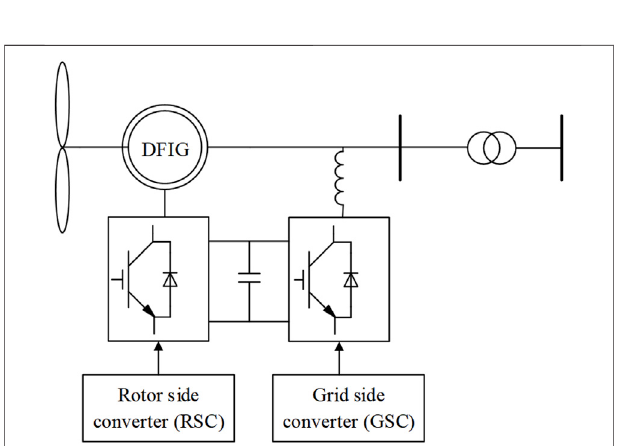
FIGURE2| Basicstructuraldiagramofadoublyfedinductiongenerator.